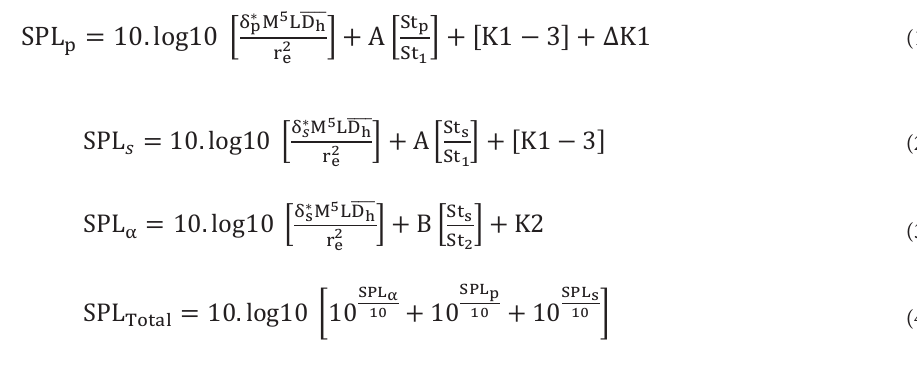
The Strouhal number, St, is used for describing oscillating flows which involve center frequency in pressure spectrum as well as characteristic dimension of source. For flow over aerofoil it is function of pressure and suction side displacement thickness, given by Eq.